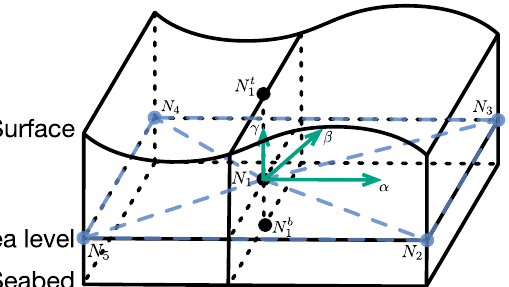
t N b i and i represent the corresponding node i